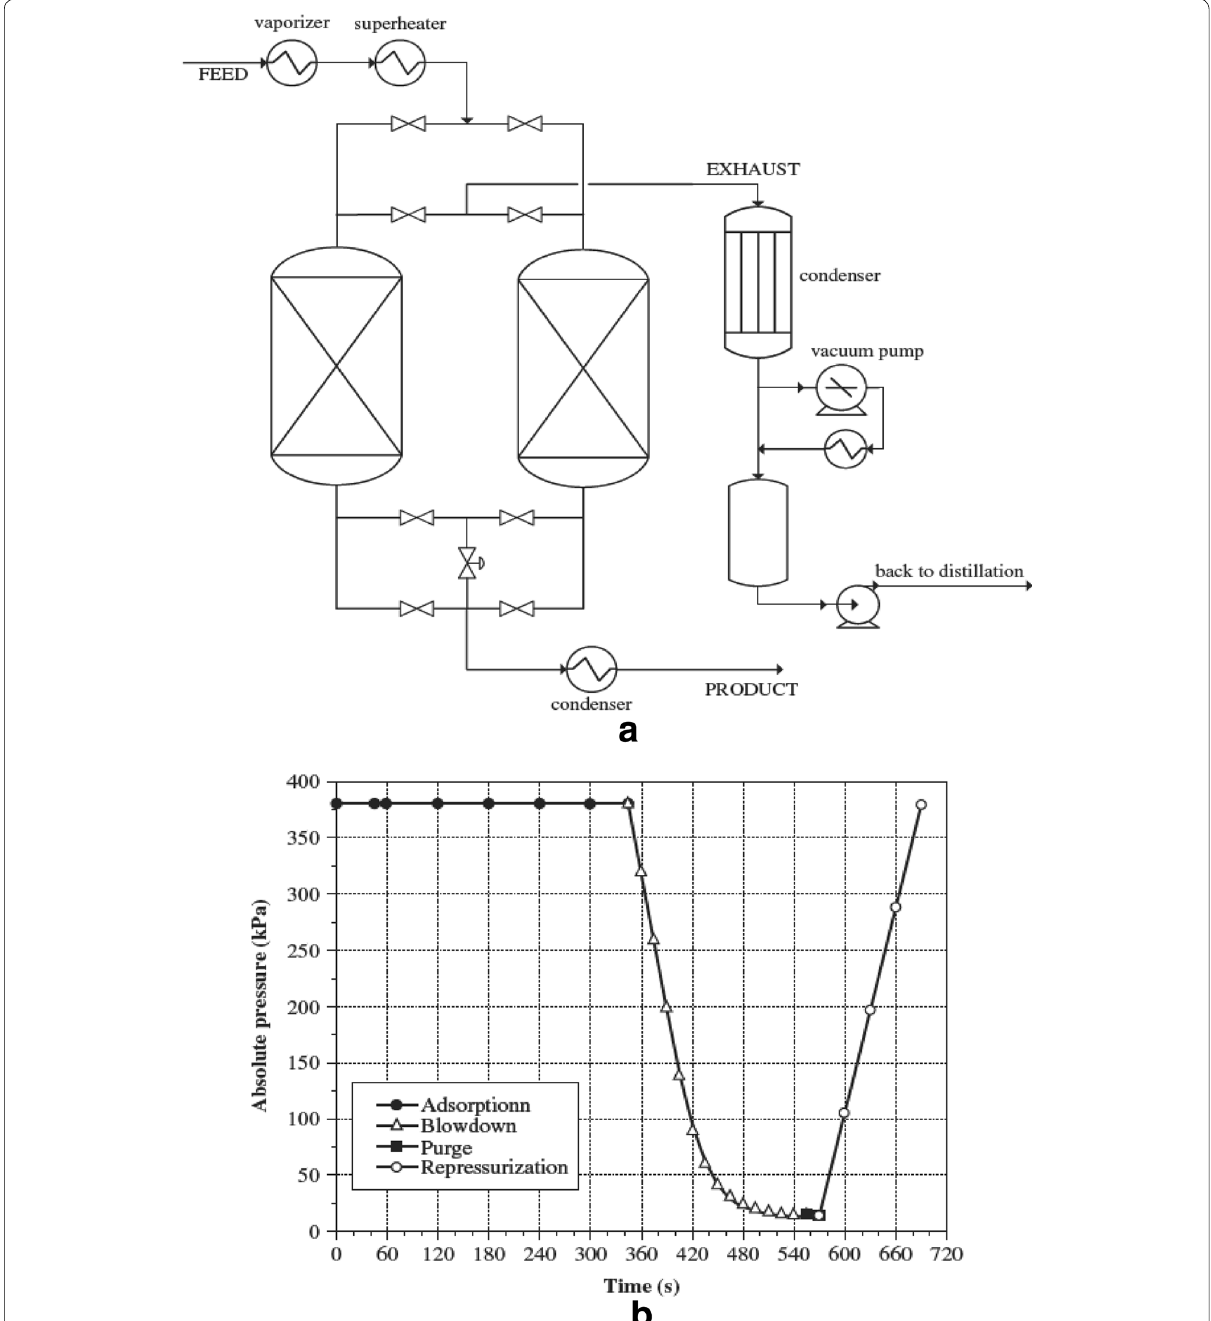
Fig. 1 Pressure swing adsorption: a two bed pressure swing adsorption process [Ref. (Simo 2013)] Copyrights John Wiley and Sons, 2013. Reprinted with permission from the publisher. b Pressure profile for two-bed ethanol PSA cycle [Ref. (Simo 2008)] Copyrights Elsevier, 2008. Reprinted with permission from the